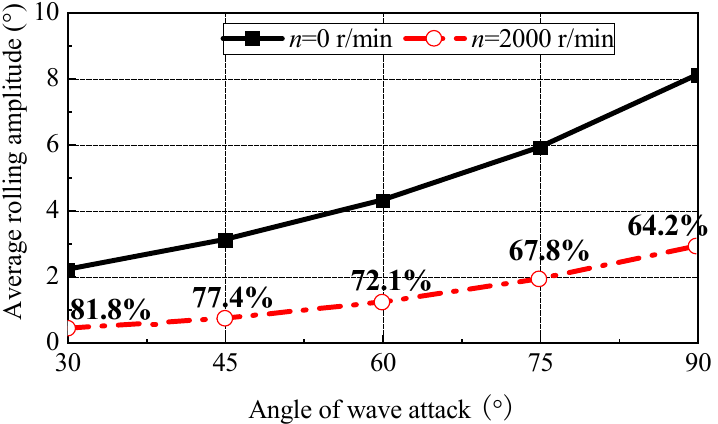
Figure 16. Average roll amplitude of the ship and average anti-roll rate for varying wave encounter angles.